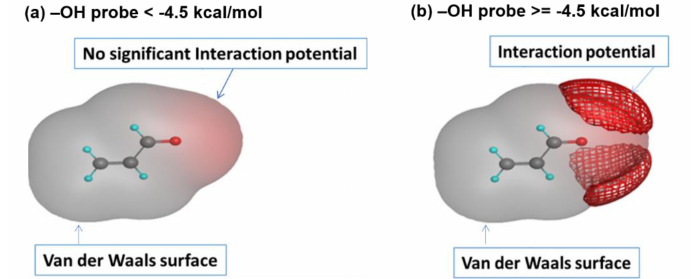
Figure 6. Visualization of Van der Waals surface and interaction potential surface of acrolein: ( a ) –OH probe < − 4.5 kca/mol, and ( b ) –OH probe ≥ − 4.5 kca/mol.